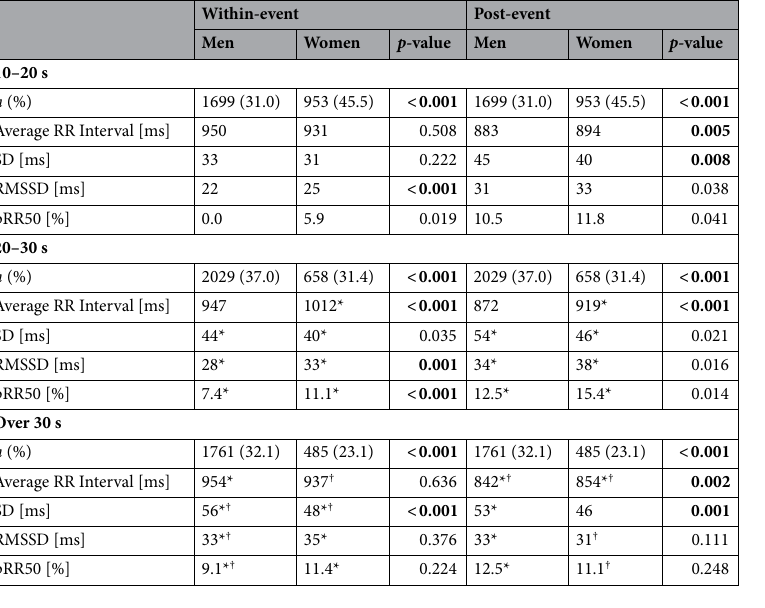
Table 2. Within- and post-event time-domain HRV parameter values in different apnea duration groups for men and women. Medians of parameters were calculated from electrocardiogram recorded during apnea events (within-event) and within a 15-s segment following the apnea event (post-event). The p -values presented in the table denote the statistical significance of the differences between men and women; the p -values indicating statistically significant differences ( p < 0.01) are bolded. Mann–Whitney U test was used for continuous and χ 2 -test for discrete variables. HRV heart rate variability, n the number of apneas, SD standard deviation of RR intervals, RMSSD root mean square of successive differences, pRR50 the number of adjacent RR intervals differing more than 50 ms divided by the total number of RR intervals during the apnea. *Statistically significant difference ( p < 0.01) compared to the 10–20 s apneas. † Statistically significant difference ( p < 0.01) compared to the 20–30 s